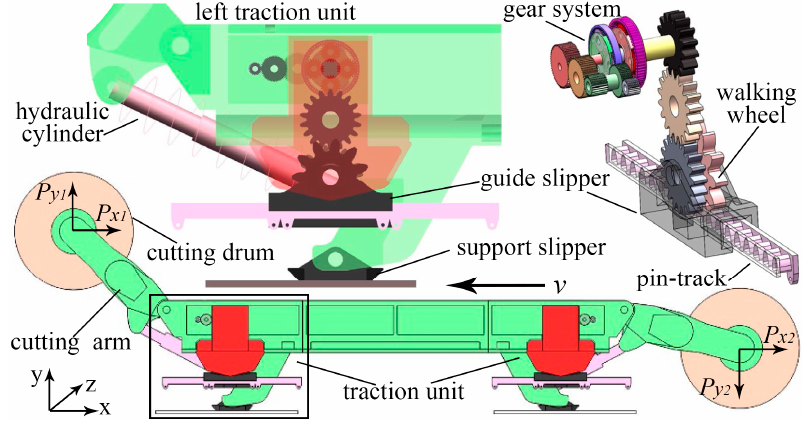
Figure 1. Prototype model of the shearer and its traction unit.